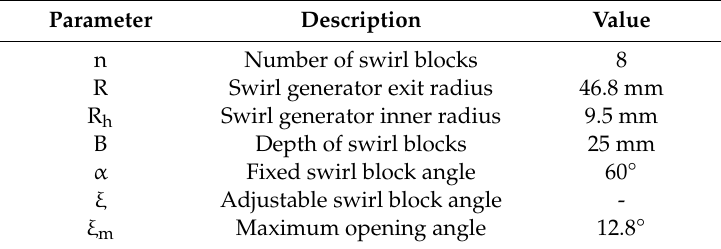
Table 1. Parameters for evaluating the swirl number.